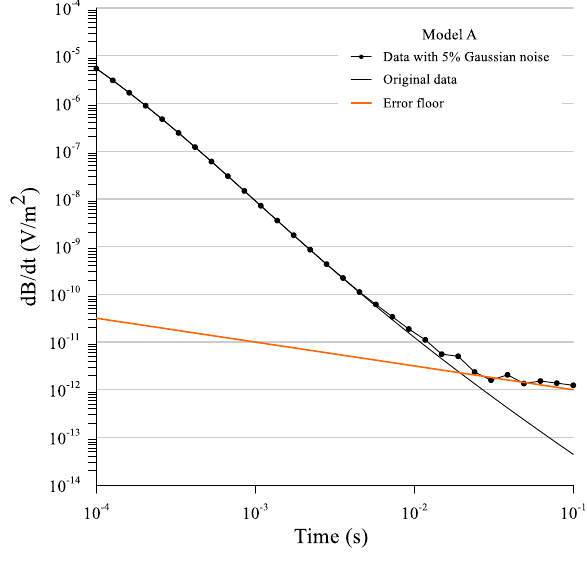
Fig. 2 5% Gaussian noise added in synthetic data. We adopt the transient electromagnetic noise model proposed by Munkholm and Auken (1996) and take model A as an example to show the morphology of 5% Gaussian noise in the synthetic